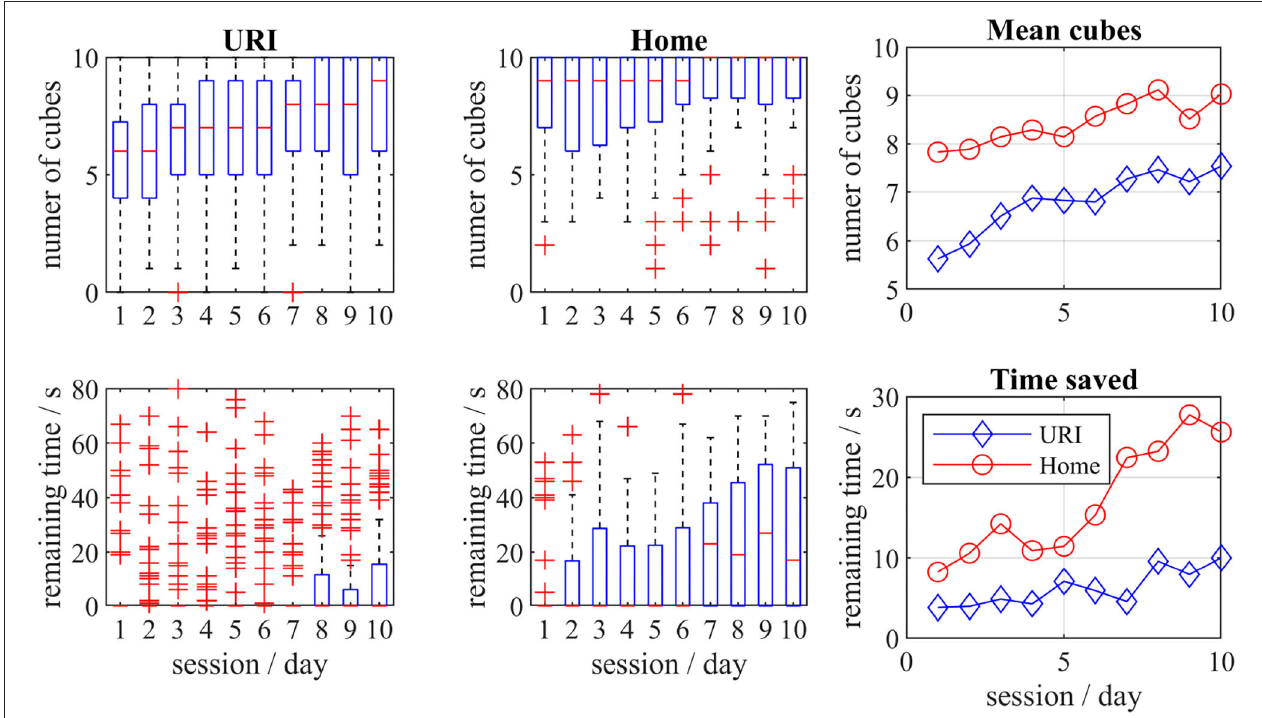
FIGURE 6 | The boxplots for the number of successfully placed cubes and the remaining time for home and hospital (URI) groups. The mean values for both groups per sessions are also presented.